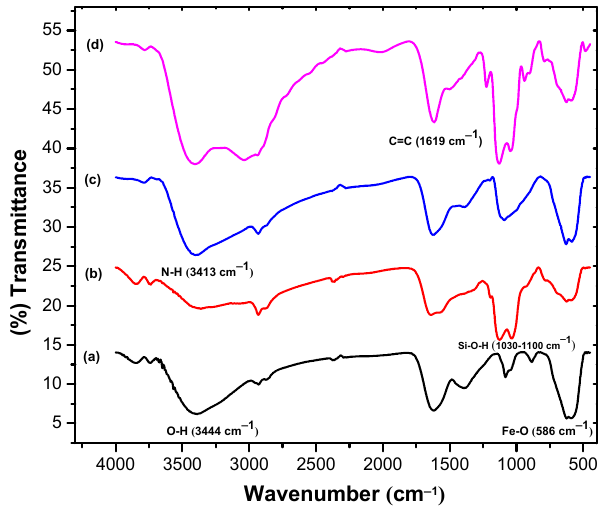
Figure 4. FTIR spectra of ( a ) Fe 3 O 4 , ( b ) Fe 3 O 4 @APTMS, ( c ) Fe 3 O 4 @APTMS-GA, and ( d ) Fe 3 O 4 @APTMS-GA-acrylate.